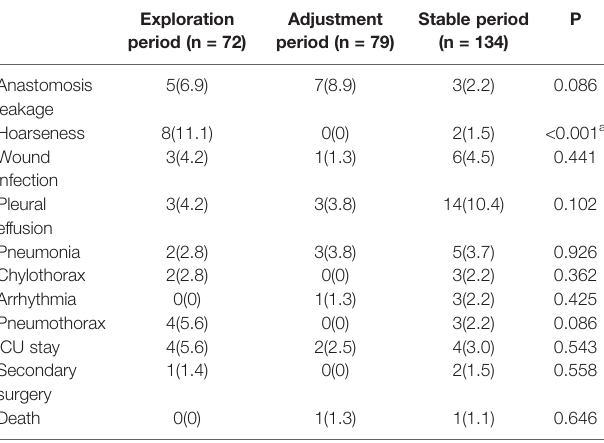
TABLE 3 | Postoperative complications of the three